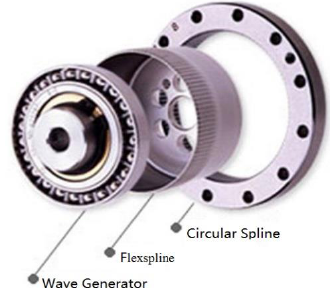
Figure 1. Harmonic drive